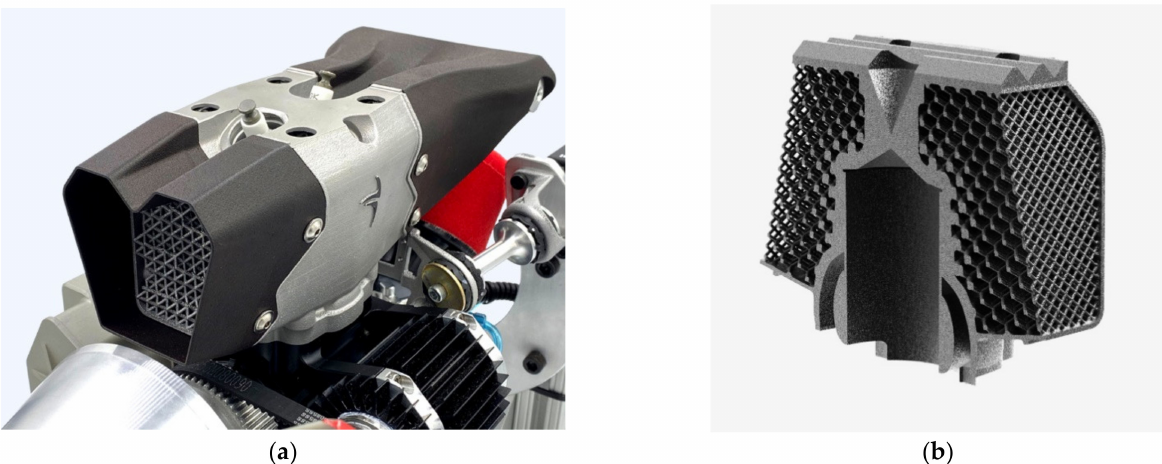
Figure 3. Microturbine generator housing ( a ); cross-section of the cooling system of the combustion engine cylinder ( b ) [38] (image courtesy of